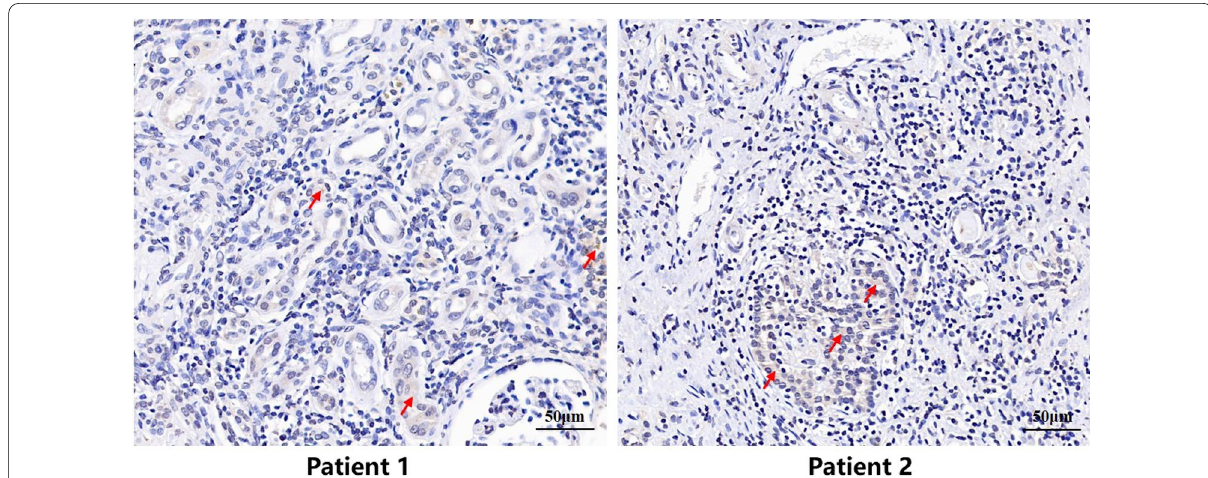
Fig. 11 Mindin protein was expressed massively in renal tubule tissues of human hydronephrosis patients by immunohistochemistry. Red arrow indicate mindin